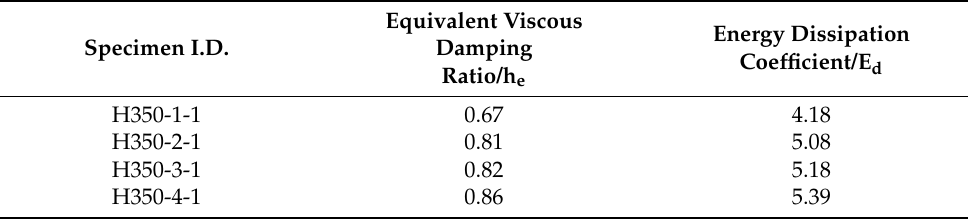
Table 6. The equivalent viscous damping ratios and energy dissipation coefficients.